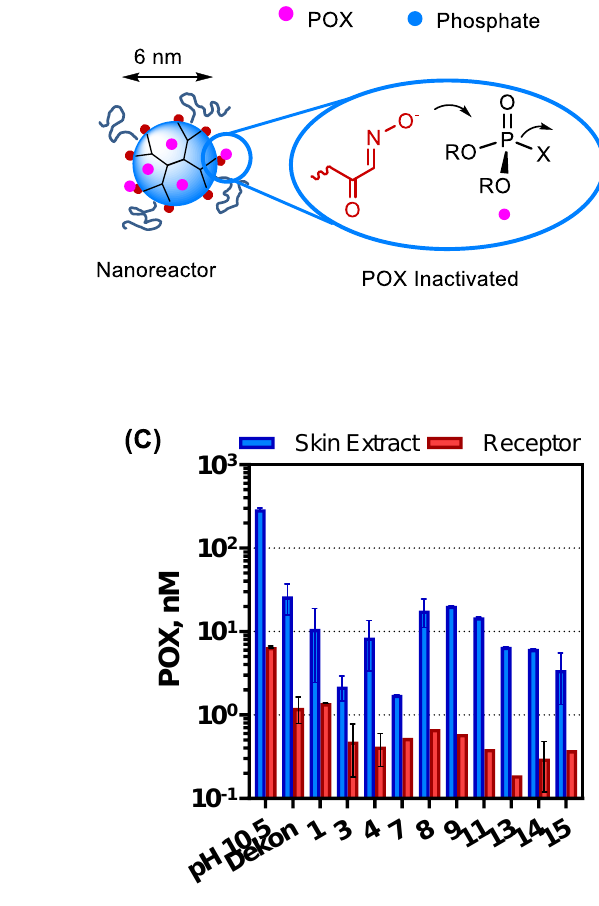
Table 2. Nanomaterial-based therapeutic platforms for applications in antidote drug delivery or reactive organophosphate (OP) inactivation.